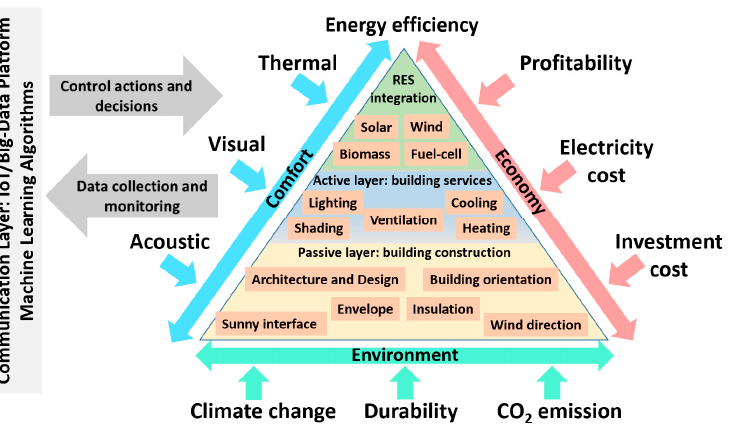
Figure 1. The building as a holistic system: main aspects for energy reduction